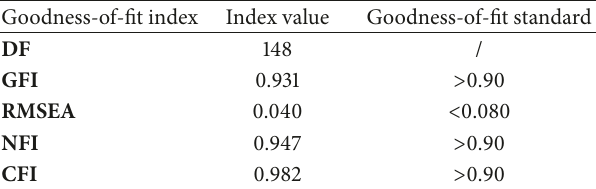
Table 6: Goodness-of-fit test of the modified